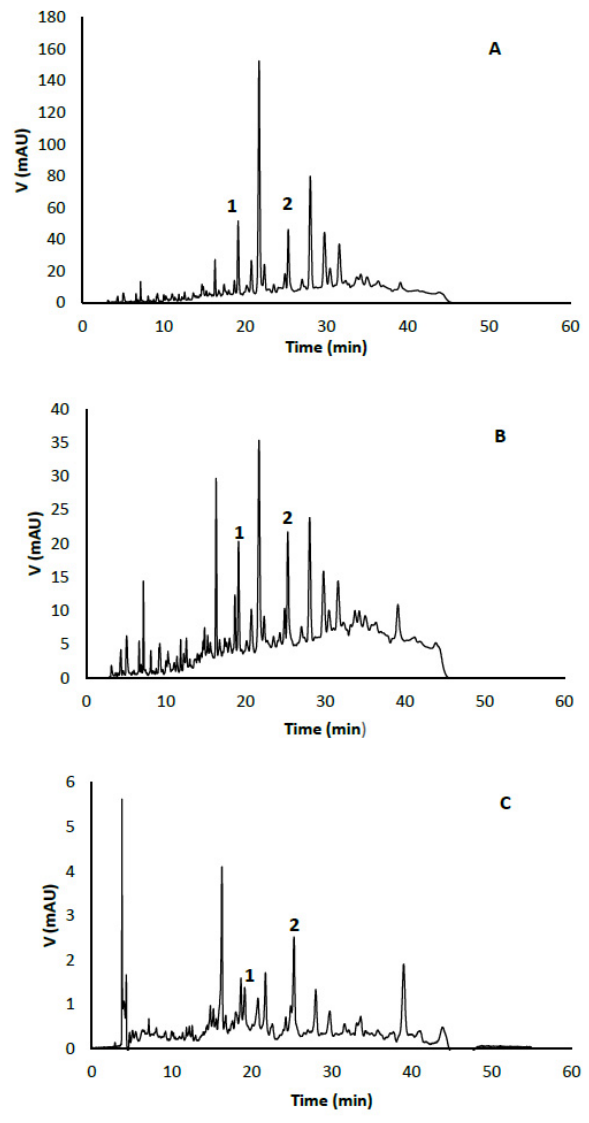
Figure 1. Phenolic profile of avocado peel extract obtained by ( A ) WGM method, ( B ) WG method, and ( C ) ES method at 280 nm: (1) chlorogenic acid; (2) epicatechin. Therefore, the extraction method had a significant effect ( p ˂ 0.001) on the epicatechin concentration obtained. Figueroa et al. [25] reported a concentration of epicatechin 59/100 g peel dm using a microwave-assisted extraction (MAE) and ethanol (36%) as the solvent.